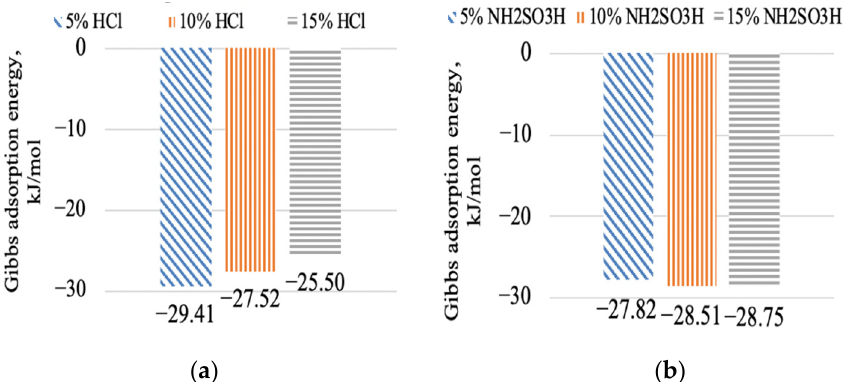
Figure 11. Dependence of the Gibbs adsorption energy values of corrosion inhibitors IC-1 and IC-2 in hydrochloric acid after 6 h ( a ) and in sulfamic acid after 24 h ( b ). The values of the Gibbs adsorption energy obtained in Figure 11a were negative, which indicated significant adsorption of inhibitor molecules on the surface of steel plates.